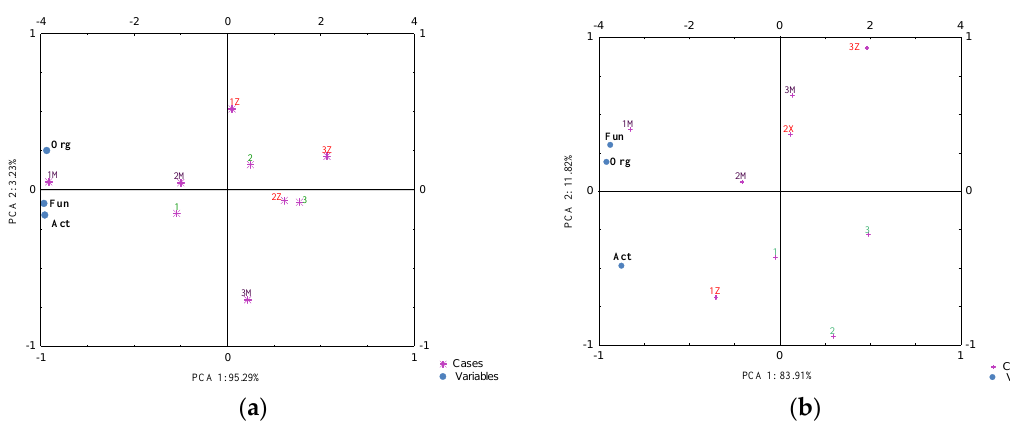
Figure 2. Count of selected groups of microorganisms in soil contaminated with cobalt: ( a ) loamy sand; ( b ) sandy clay loam; Org—organotrophic bacteria; Act— Actinobacteria ; Fun—fungi; dose Co 2+ mg·kg −1 d.m. of soil: 1—0; 2—20; 3—80; Z—zeolite Bio.Zeo.S.01; M—molecular sieve.